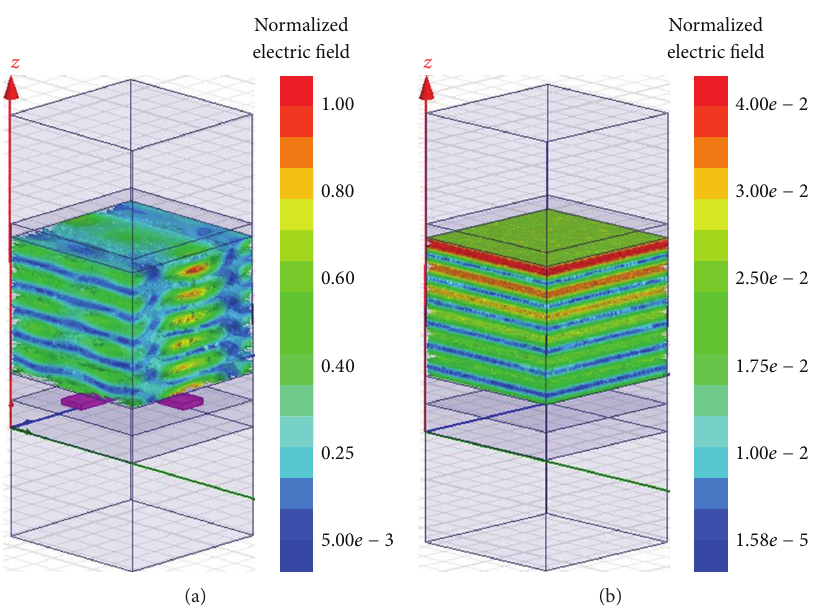
Figure 7: Electric field plot with (b) and without (a) the